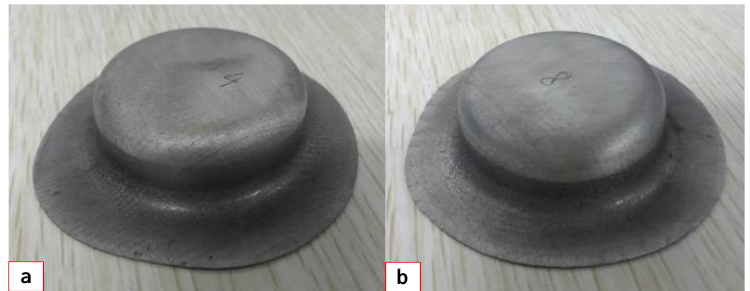
Figure 13. Hot stamping parts of experimentally stamped ZK60 magnesium alloy: ( a ) Obtained part at the parameters of compromise solutions 1; ( b ) Obtained part at the parameters of compromise solutions 2.